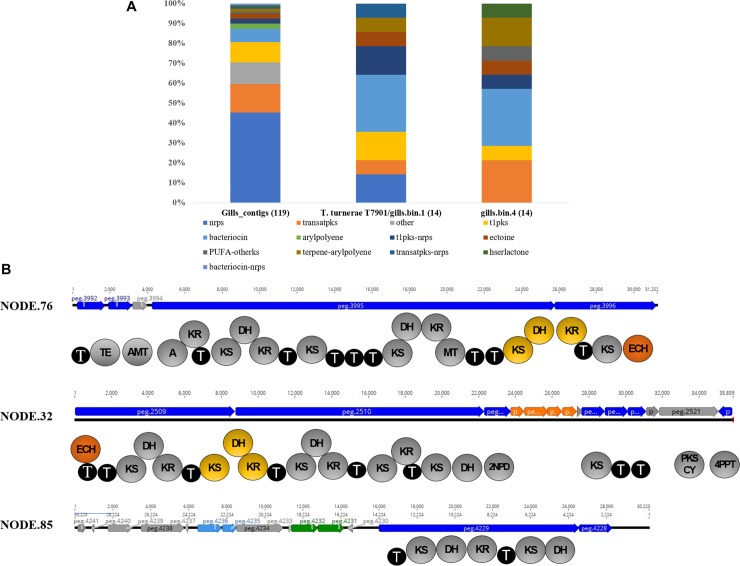
Gill genome bins contigs for Biosynthetic Gene Clusters (BGCs).A) Secondary metabolomes. BGCs/contigs detected in Teredinibacter turnerae (T7901 and gills.bin.1), Teredinibacter sp.(gills.bin.4) and on contigs derived from N. reynei gill assembled dataset. Clusters are grouped, and color coded according to the compound class. B) Novel putative trans-AT PKS biosynthetic gene clusters detected on Teredinibacter sp. gills.bin.4 genome and the main predicted catalytic domains of their open reading frames (ORFs). Biosynthetic, transport-related, regulatory, other β-branching-related genes are color coded in dark-blue, light-blue, green, gray and orange respectively. antiSMASH gene clusters abbreviations (not cited on the main text body): PUFA—Polyunsaturated fatty acids; hrslactone–homoserine lactone. Domains keys: thioesterase (TE), aminotransferase (AMT), adenylation (A), ketosynthase (KS), ketoreductase (KR), dehydrogenase (DH), thiolation (T), enoyl-CoA dehydratases (ECH), 2-Nitropropane dioxygenase (2NPD), polyketide synthase cyclase (PKS CY), 4'-phosphopantetheinyl transferase (4PPT). Putative inter-proteins bimodules are present in yellow, PKS-encoded ECH catalytic domains are present in orange.